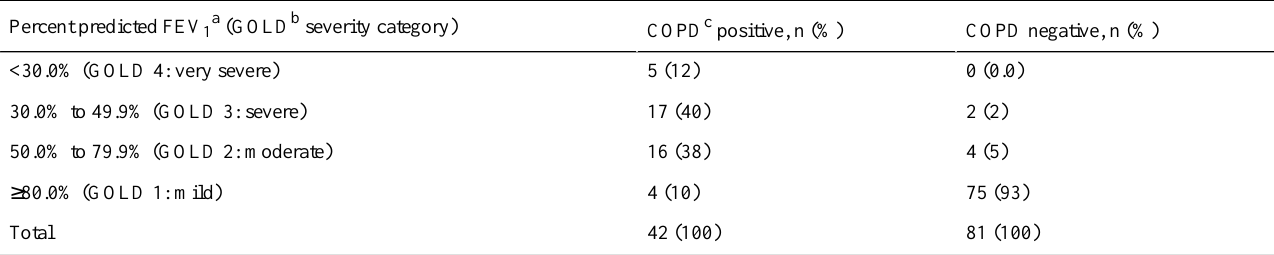
Table 4. Spirometry-derived FEV 1 (GOLD severity categories) in participants with and without COPD [2].